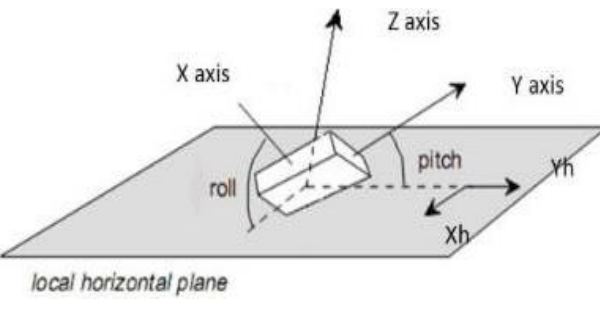
Figure 1. Schematic diagram of the angle.